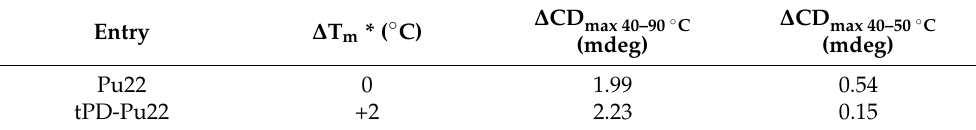
Table 1. Summary of the CD and CD melting data for Pu22 and the complex tPD-Pu22. ∆ T m is the variation in the melting temperature of the complex with respect to the Pu22 reference; ∆ CD max 40–90 is the difference in the CD value at the λ max between 40 (folded state) and 90 ◦ C (unfolded), whereas ◦ C. ∆ CD max 40–50 is the one between 40 and 50